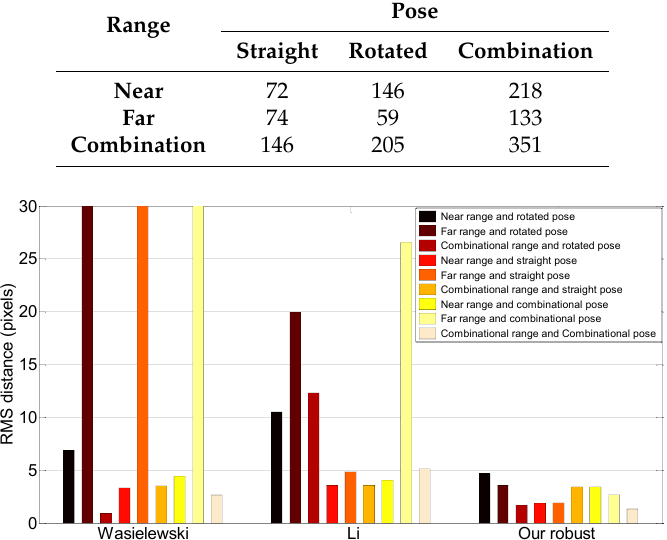
Table 1. Number of images and LiDAR scan pairs by the range and pose of the calibration target. Pose Range Straight Rotated Combination Near 72 146